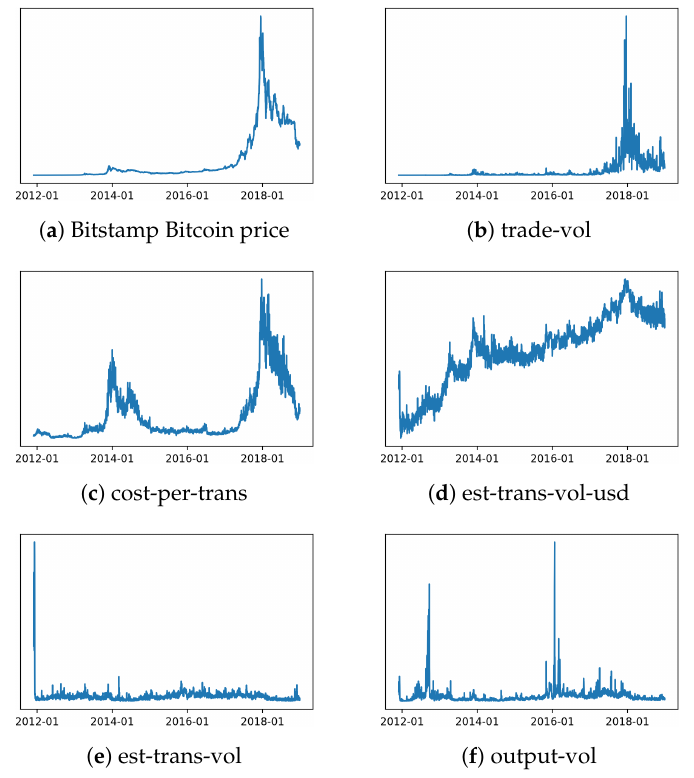
Figure 3. Changes in the values of selected